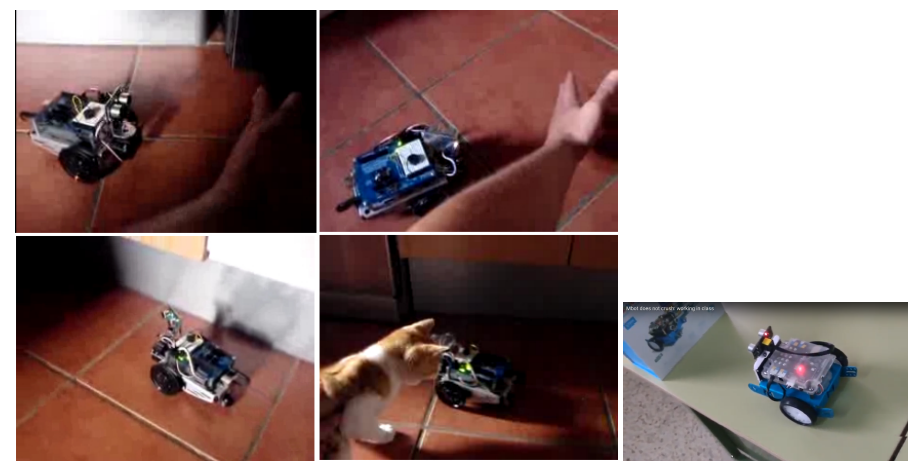
Figure 8. Navigation practice avoiding obstacles through US in Arduino and in